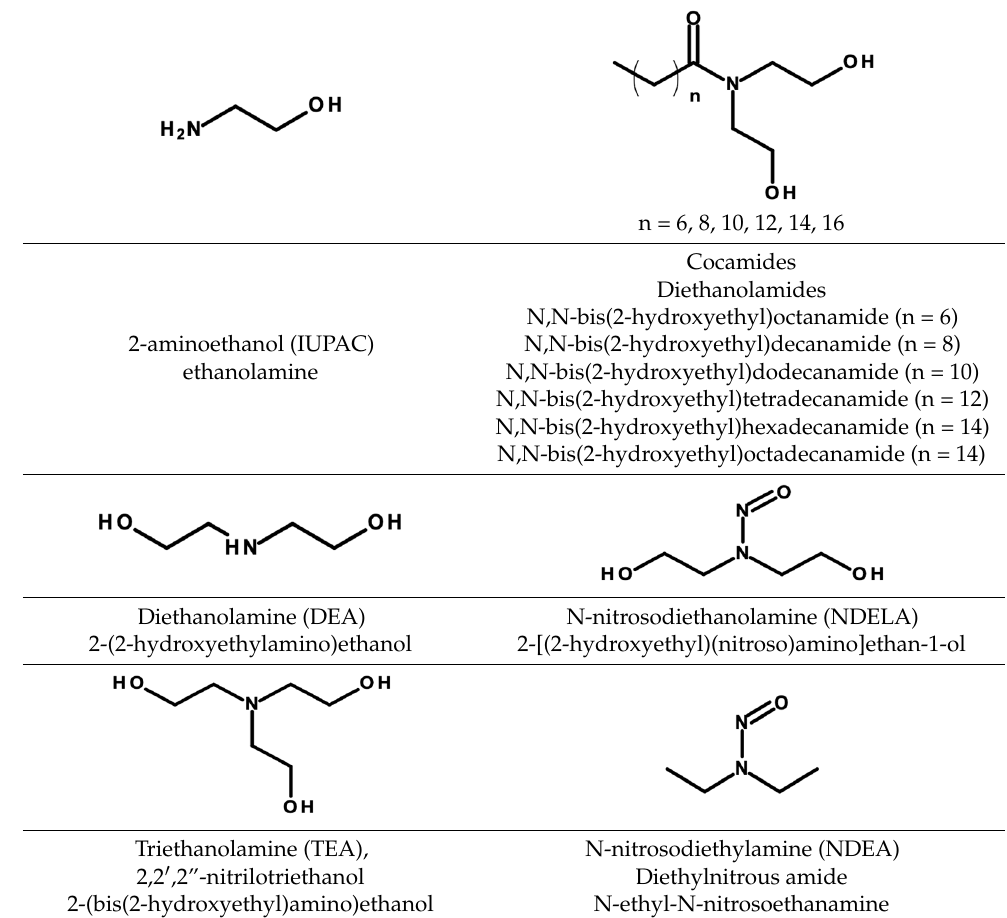
Table 3. Chemical structure of ethanolamines and their derivatives.